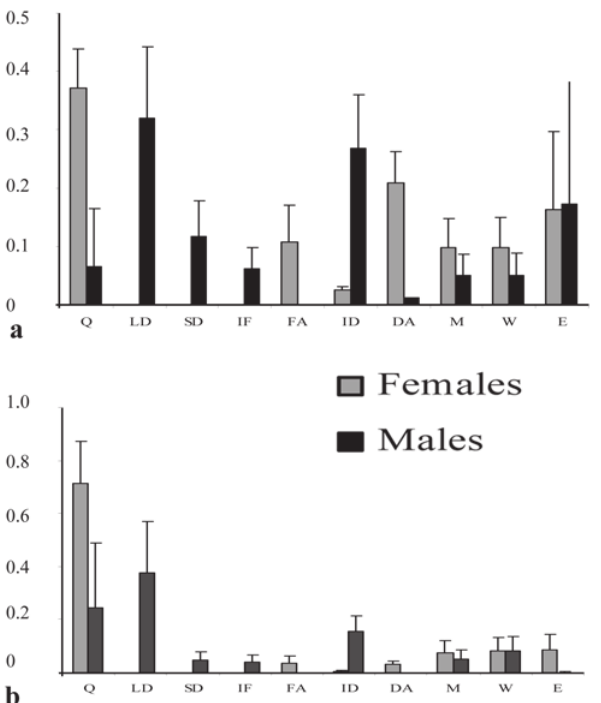
Fig. 4. Relative frequency (a) and time (b) of behavioral units of males and females in Austrolebias reicherti . Abbreviations of units shown in Table